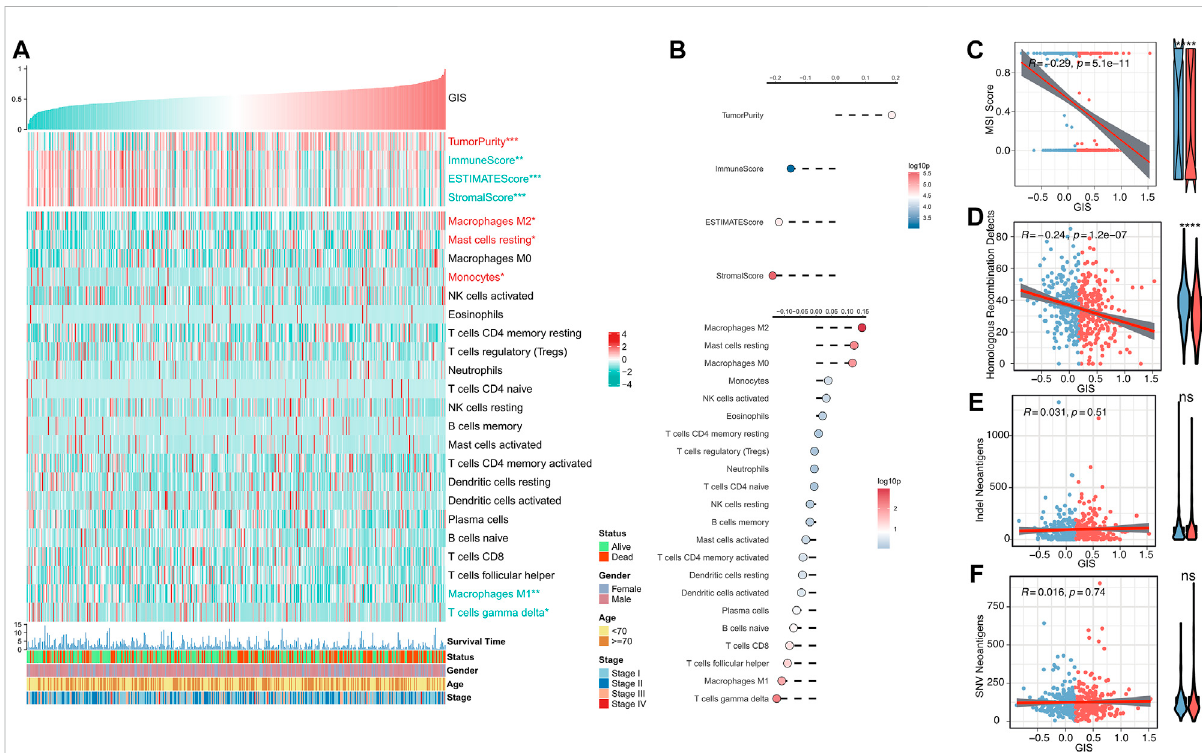
FIGURE 5 Immune landscape oftheGISriskmodel. (A) Heatmapsofthecorrelations amongGIS,estimatescore,immune cellin fi ltration abundance,and clinicalfeatures.Rednamewith*representsupregulationinthehighGISgroup,andgreennamewith*representsupregulationinthelowGISgroup; * p < 0.05,** p < 0.01,*** p < 0.001. (B) CorrelationanalysisofGIS,estimatescore,andimmunecellin fi ltrationabundance(toptobottom).Scatterand box plots of the correlation between GIS and (C) MSI score, (D) HRD score, (E) indel neoantigens, and (F) SNV neoantigens. Indel, insertion and deletion; GIS, glycolysis – immune score; MSI, microsatellite instability; HRD, homologous recombination de fi ciency; SNV, single-nucleotide